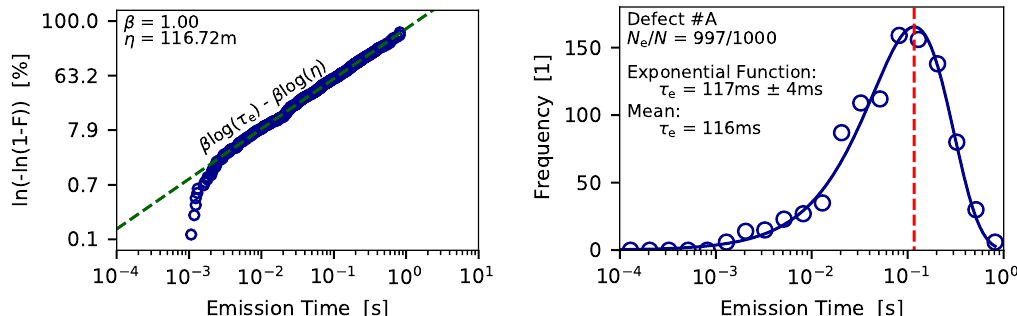
Figure 8. ( left ) The Weibull percentile function of the emission times indicates that the emission times follow an exponential distribution. ( right ) By binning the emission times into a histogram and applying the exponential distribution function the average emission time of the defect can be calculated. An almost equal average emission time is obtained when the mean value of transition times is